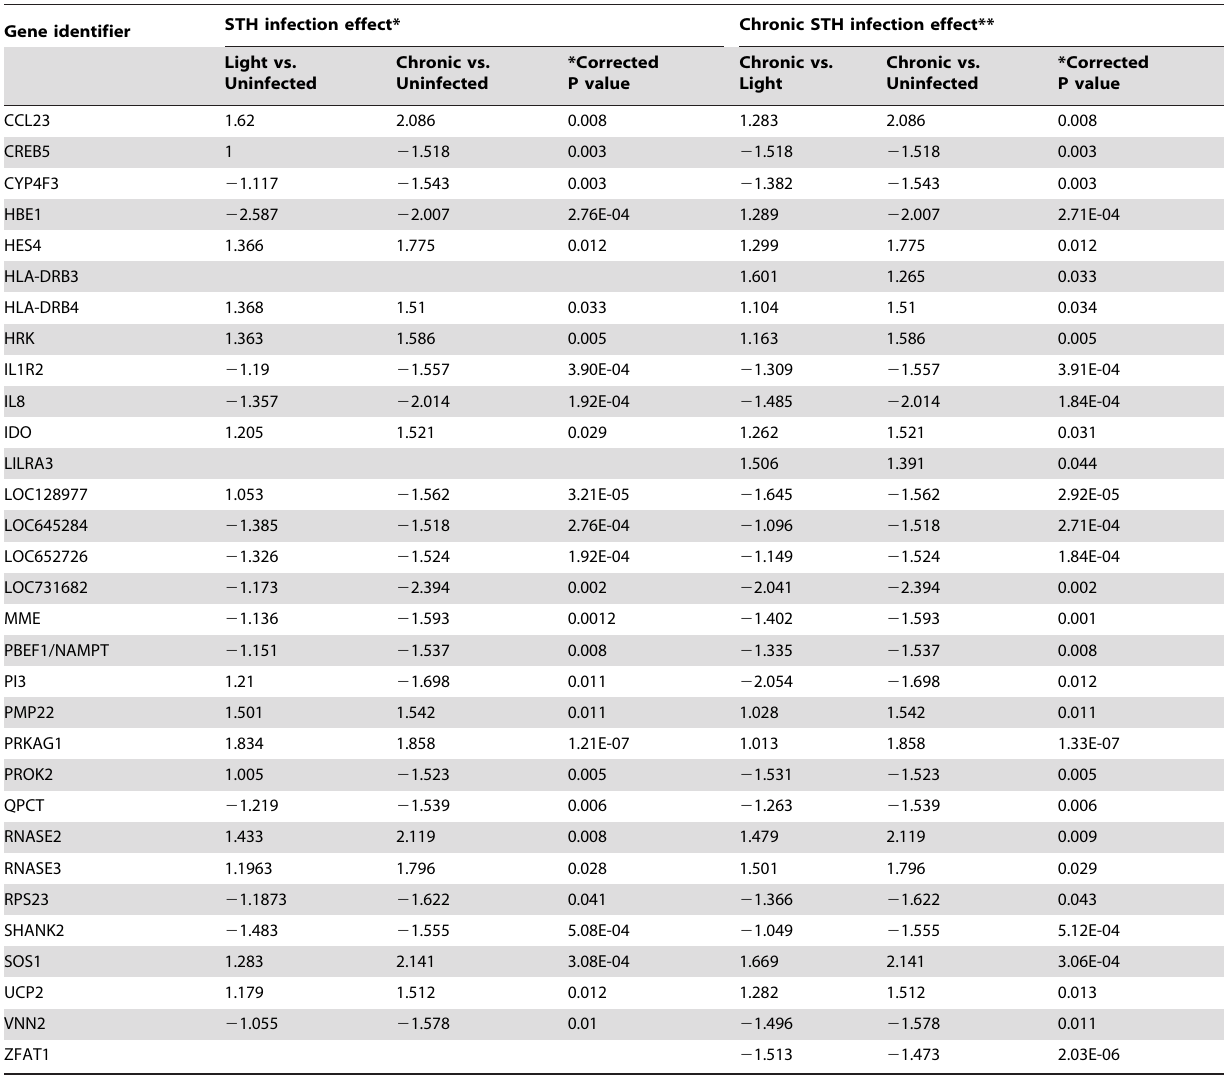
*STH infection effects represent a comparison of infected (chronic + light) vs. uninfected groups. **Chronic STH infection effects represent a comparison of chronic vs. non-chronic (light + uninfected groups) groups. P values are corrected for multiple comparisons and represent the overall STH infection and chronic infection effects.